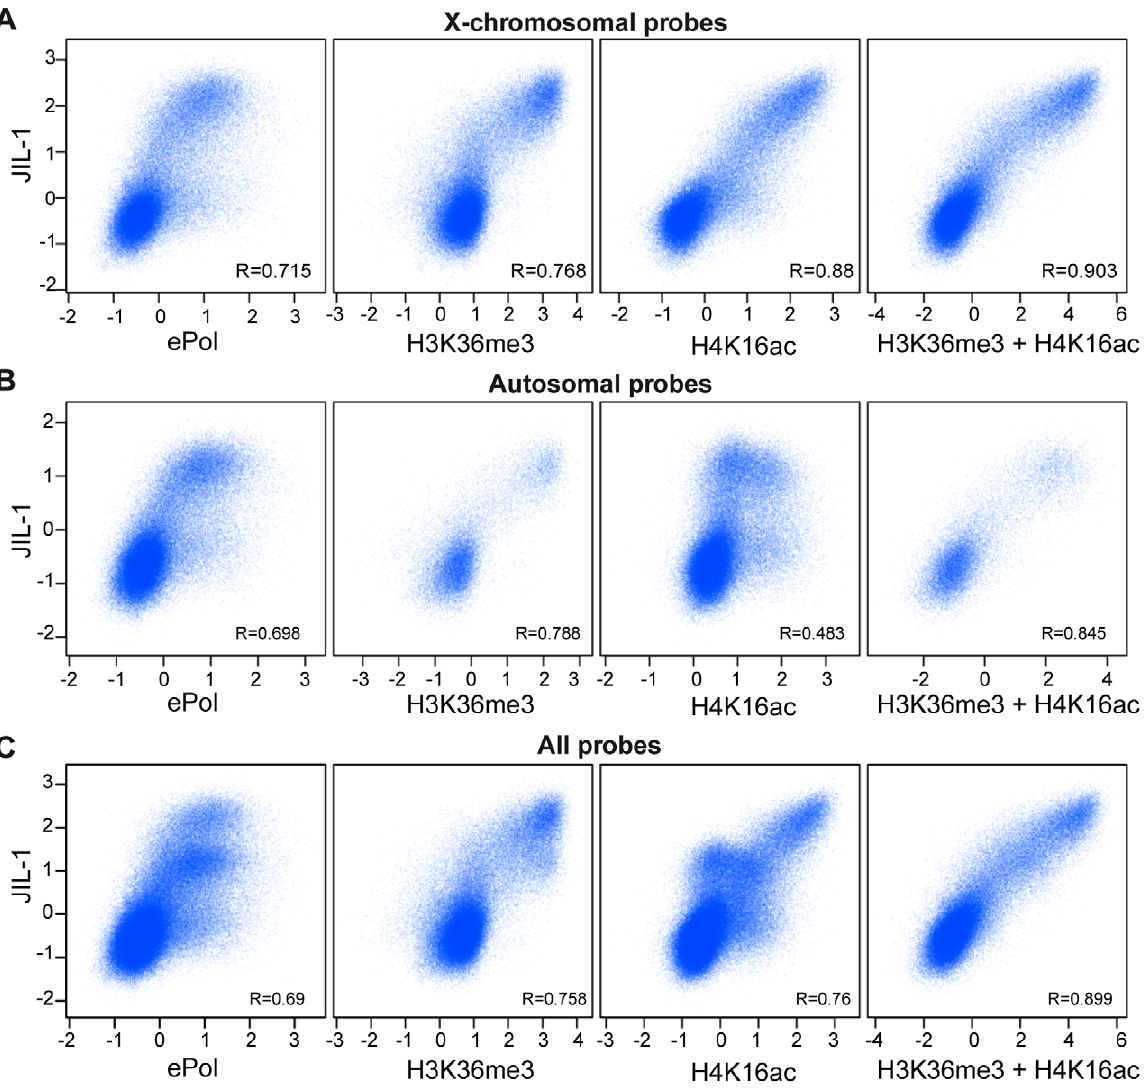
Figure 8. Correlations of H3K36me3, H4K16ac, and JIL-1 binding. Pair-wise correlations of JIL-1 versus ePol, H3K36me3, H4K16ac and the sum of H3K36me3 and H4K16ac signals in unified 200 bp sampling windows. (A) Results for the X chromosome (B) for autosomes (C) and for the entire genome. Pearson correlation coefficients are provided for each panel.